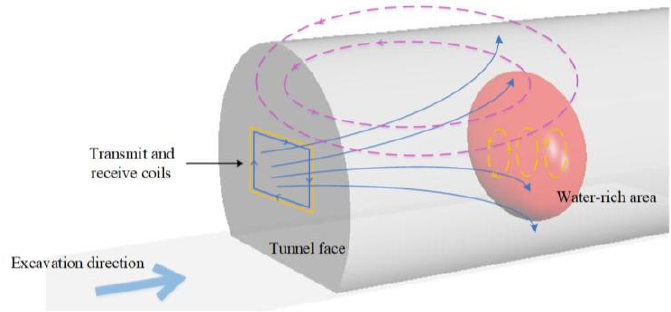
Figure 5. The working principle of the transient electromagnetic method.